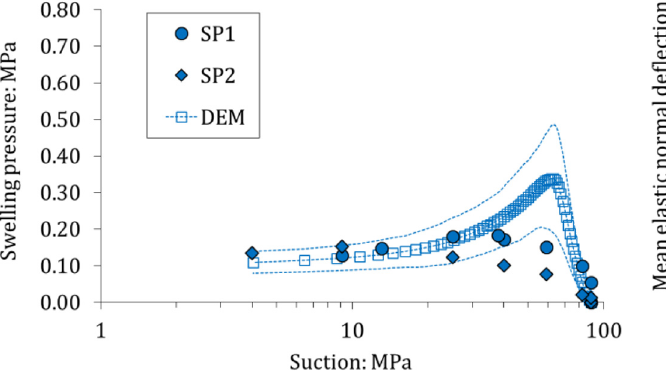
Fig. 8. Calculated increment of the mean elastic de fl ection in the contacts between the pellets and the top wall, as a function of the imposed increment of pellet radius. The dashed line represents the “ y = x